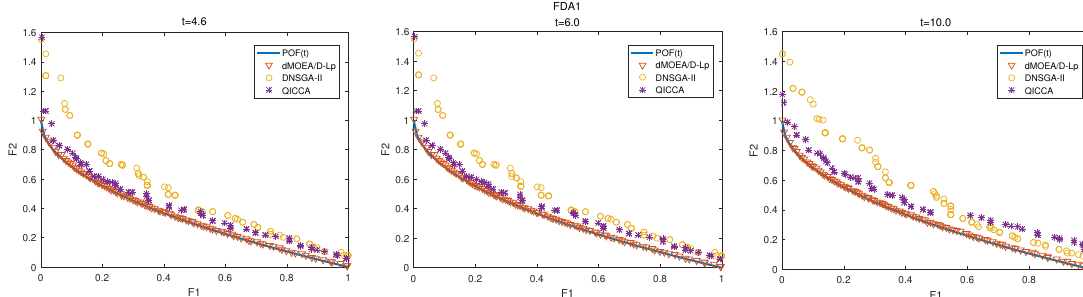
Figure 3. Solution sets obtained by three algorithms at different times on FDA1 in case of τ T = 10, n T = 10. dMOEA/D- L p : memory-enhanced dynamic multi-objective evolutionary algorithm based on L p decomposition; DNSGA-II: dynamic non-dominated sorting genetic algorithm II; POF: Pareto optimal front; QICCA: immune clonal coevolutionary algorithm for dynamic multi-objective